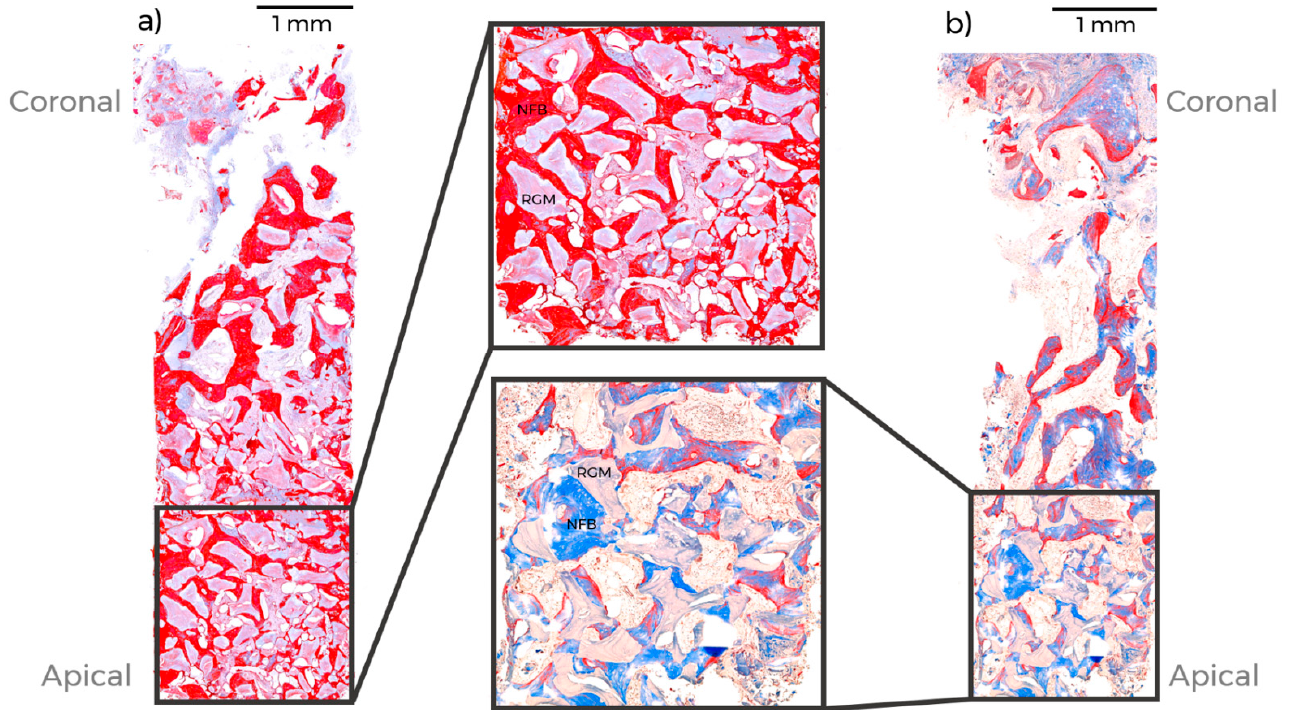
Figure 5. Photomicrographs of MT-stained histologic specimens of ( a ) Case I and ( b ) Case II.